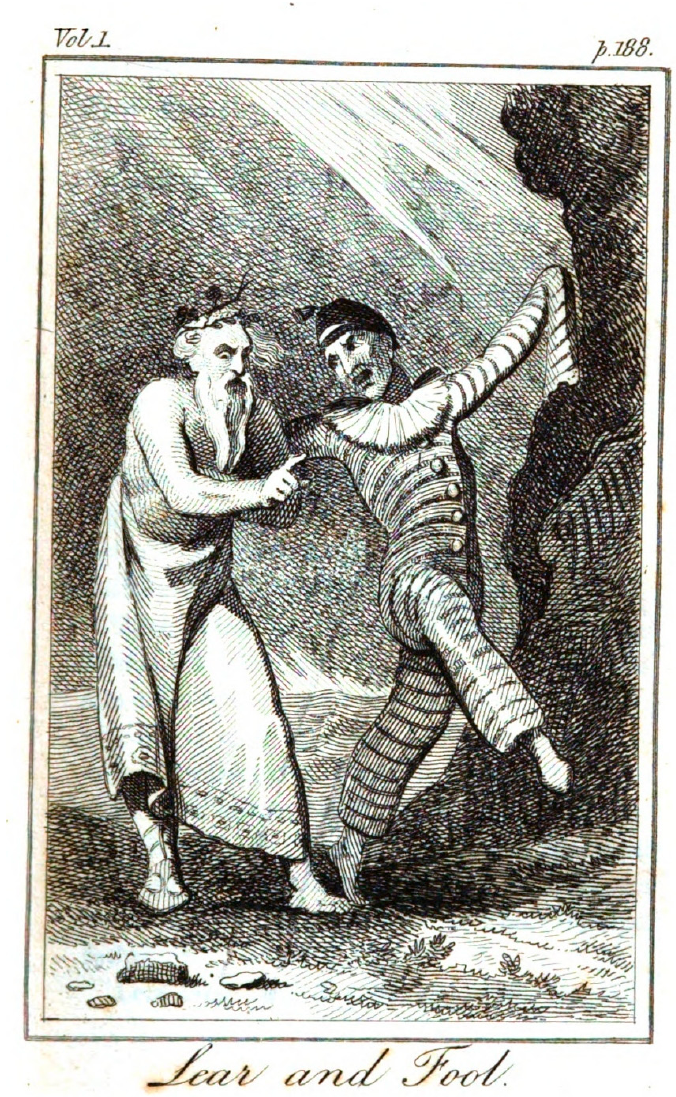
Figure 4. Engraving by William Blake (probably from a drawing by William Mulready), in Tales from Shakespeare , by C. Lamb, London, 1807, 2 vols., 1807, I.